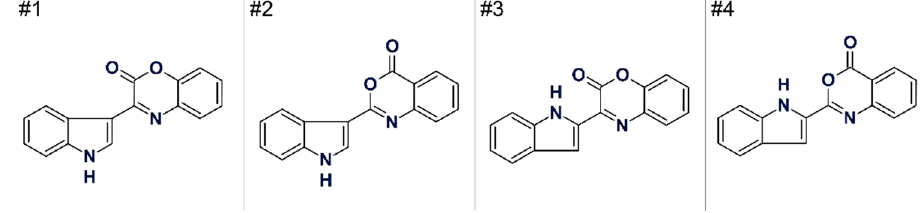
Figure 18. Possible structures of cephalandole A proposed by Gross and co-workers [55].